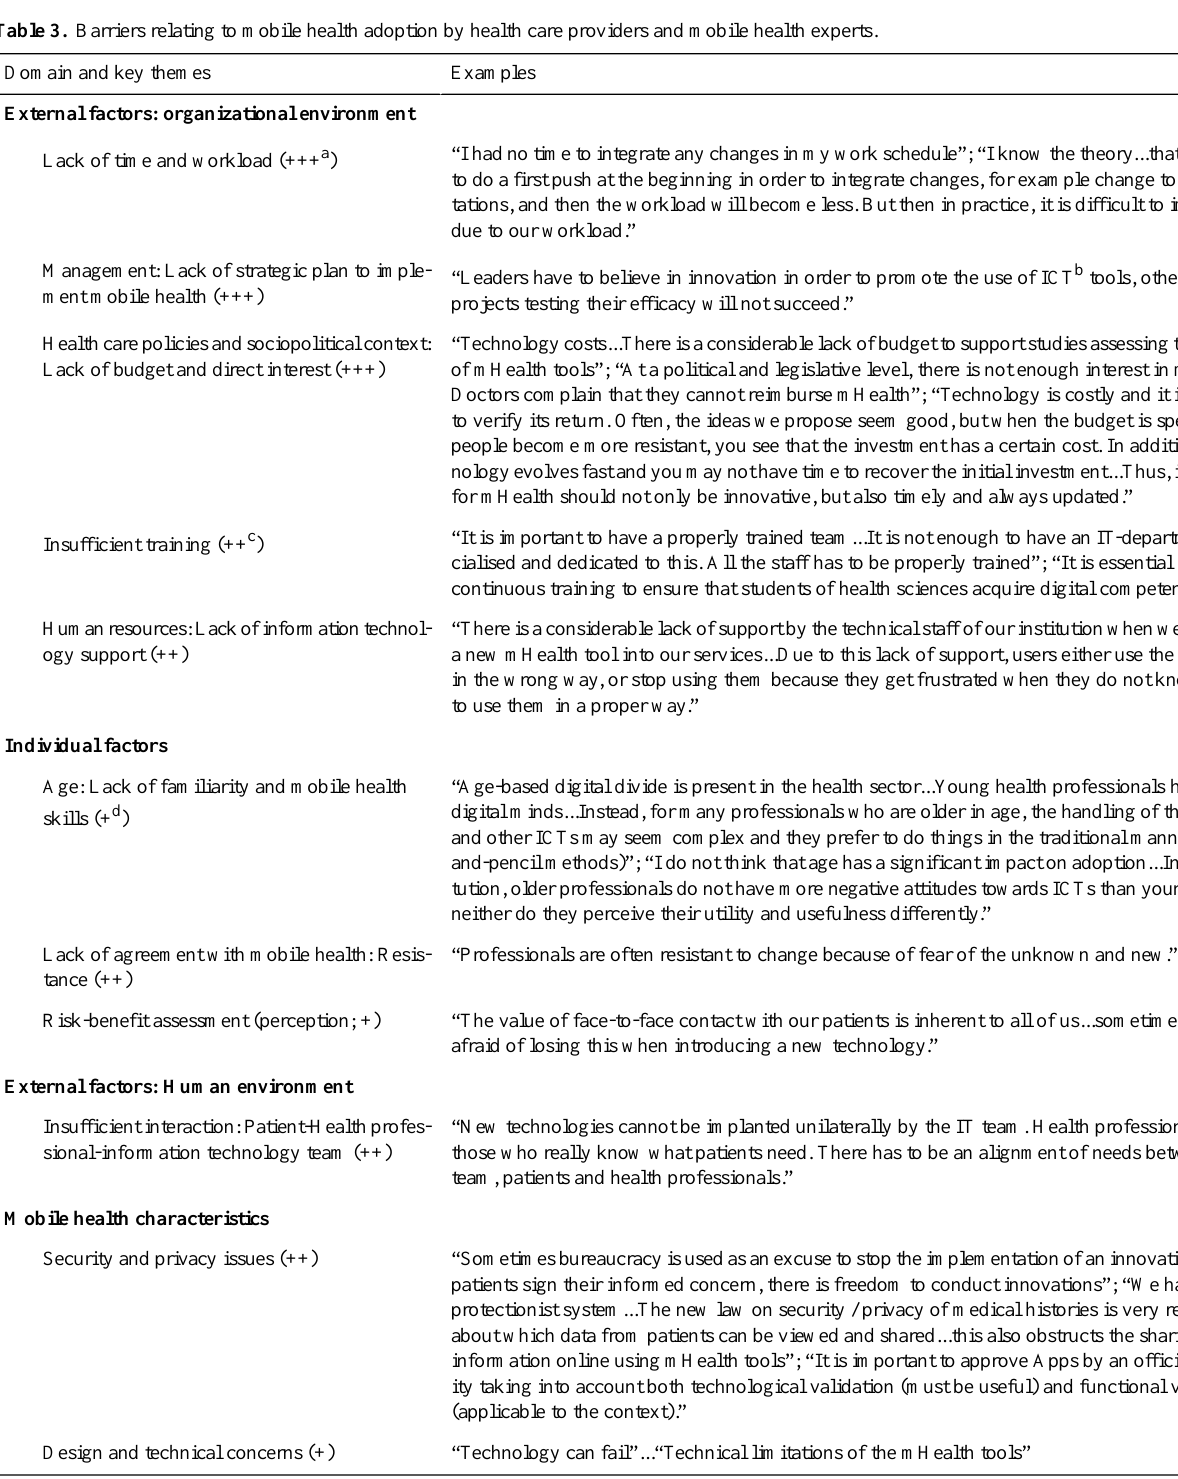
Table 3. Barriers relating to mobile health adoption by health care providers and mobile health